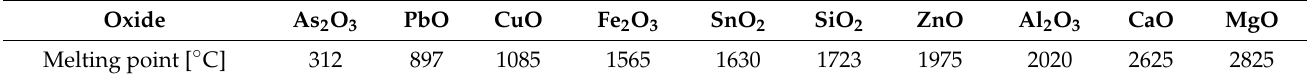
Table 1. Melting points of oxide components of slags from Cu production